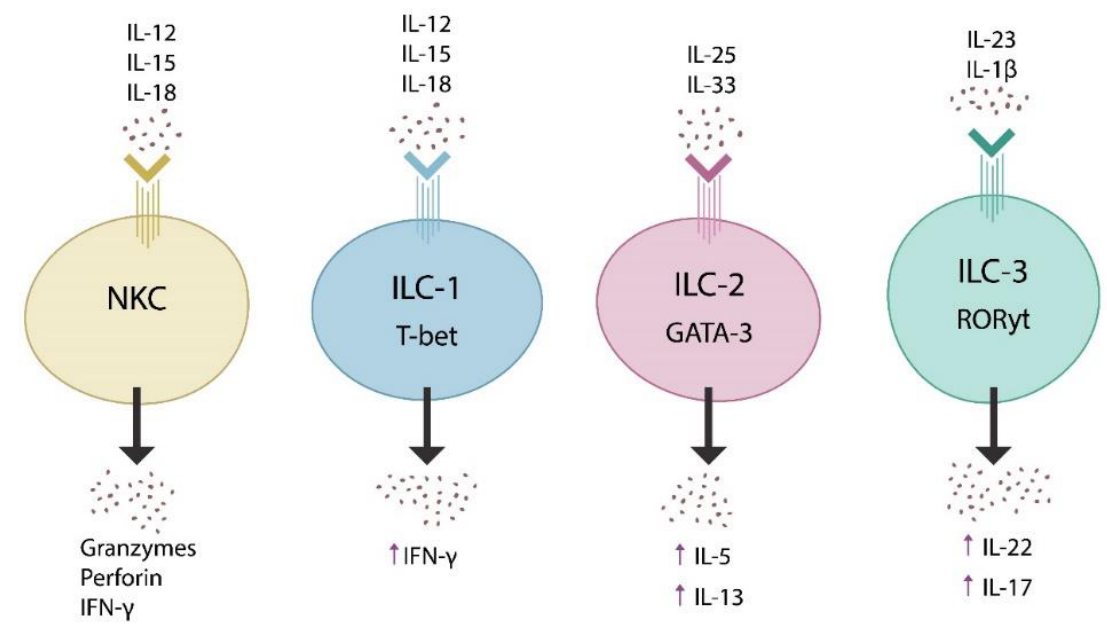
Figure 1. Innate lymphoid cells are comprised of NKCs and innate lymphoid cells types 1, 2, and 3 (ILC1, ILC2, and ILC3). These cells are activated by various cytokines ( top ), release other cytokines ( bottom ), and express transcription factors, including T-bet, GATA-3, and ROR γ t. When dysregu- lated, these lymphoid systems may trigger autoimmunity, fibrotic and neuropsychiatric illnesses.